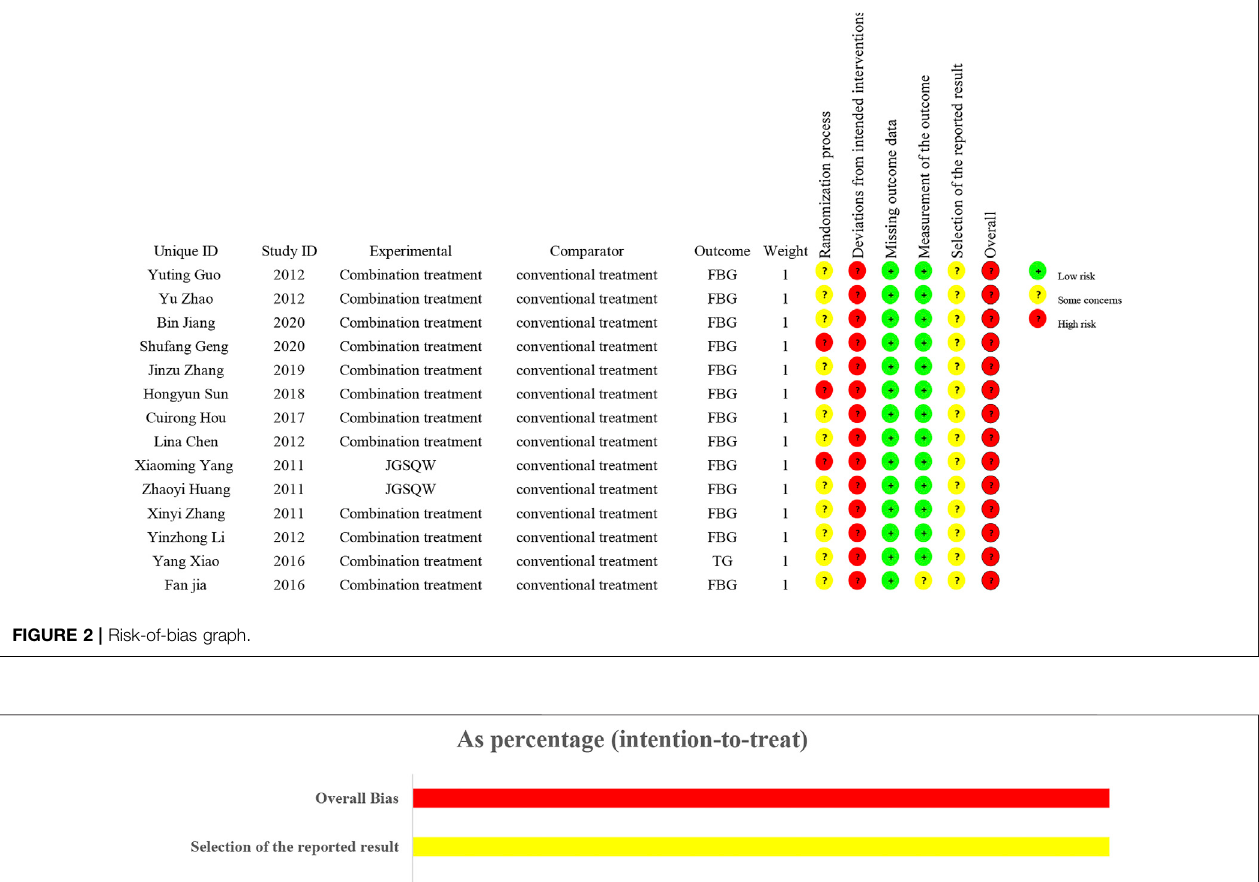
FIGURE 2 | Risk-of-bias graph.